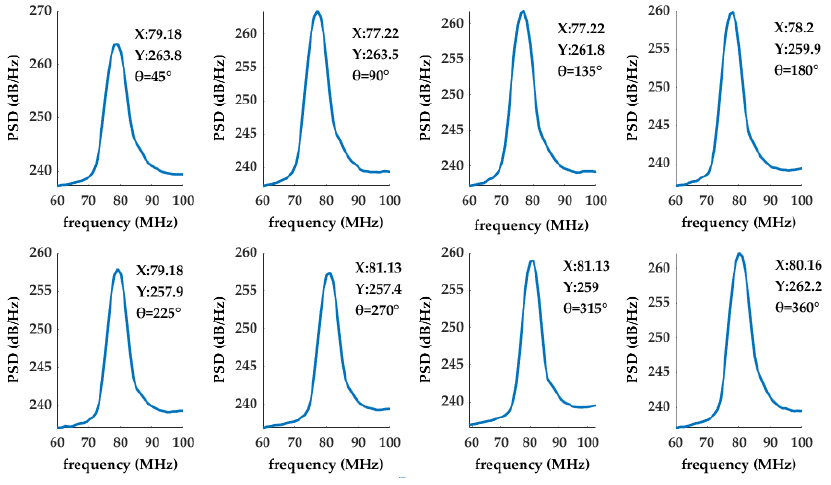
Figure 6. Beam frequency shift contrast